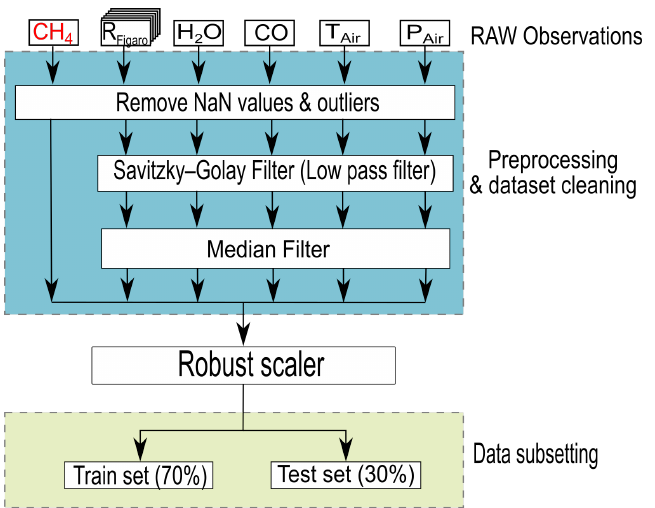
Figure 4. Data preprocessing and sub setting for the training and cross-validation of the Multi-Layer Perceptron